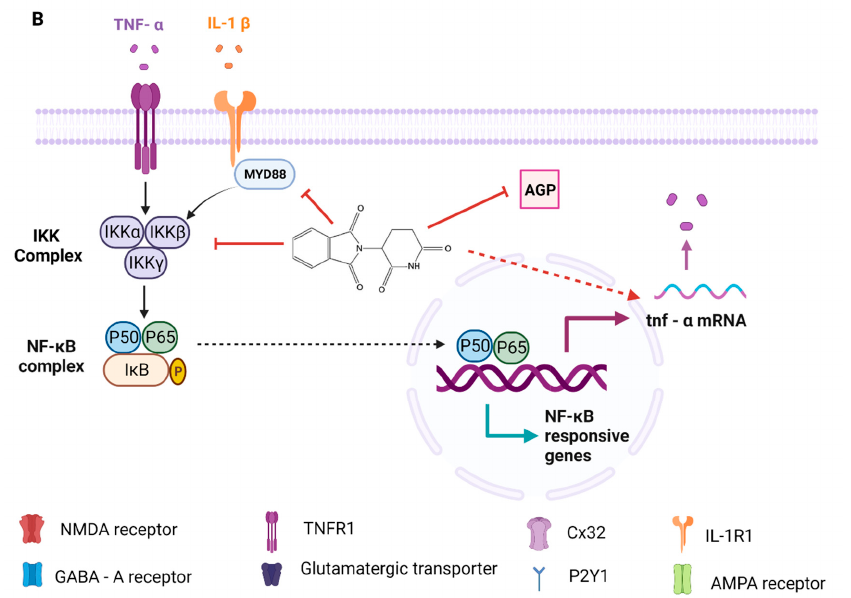
Figure 4. ( A ) Active microglia release proinflammatory cytokines, such as tumor necrosis factor alpha (TNF- α ) and interleukin 1 beta (IL-1 β ). TNF- α induces microglial glutamate release through two mechanisms (1) from gap junction CX32 hemichannels [52] and (2) by activating the TNFR1 receptor in astroglia, which in turn release ATP/ADP to activate the P2Y1 purinergic receptor increasing the intracellular calcium concentration. Glutamate interacting with NMDA receptors promotes neuroexcitotoxicity [50,51]. TNF- α also induces GABA A receptor endocytosis and recruits AMPA receptors lacking GluR2 subunits, a conformation that favors the Ca 2+ entry, amplifying the glutamate response [58] and activating TNFR1 neuronal receptors inducing cell death. IL-1 β promotes NMDA receptor phosphorylation by interacting with its IL-1R1 receptor, which increases intracellular Ca 2+ and excitotoxicity [75]. IL-1 β can also increase glutamate concentrations by inhibiting its recapture by astrocytes and neurons [76,77], as well as by increasing astrocytic release [78–80]. Thalidomide (TAL) blocks IL-1 β and TNF- α activity, decreasing neuronal damage and inflammation [34,35,73]. ( B ) Putative mechanism of action. TAL blocks TNF- α signaling by destabilizing the 3’unstranslated region (3 ´ UTR) of TNF- α mRNA, inhibiting TNF- α protein synthesis [73]. TAL blocks nuclear factor kappa B (NF- κ B) signaling which induces the expression of various pro-inflammatory genes by blocking the IKK complex [34,35] and via myeloid differentiating factor 88 (MyD88) [67]. Finally, TAL also can inhibit TNF- α by blocking α 1-acid glycoprotein (AGP) [69]. Orange arrows represent the IL-1 β processes while purple arrows represents the TNF- α processes. TAL mechanism are in red arrows. Imagen created with BioRender.com (accessed on 20 February